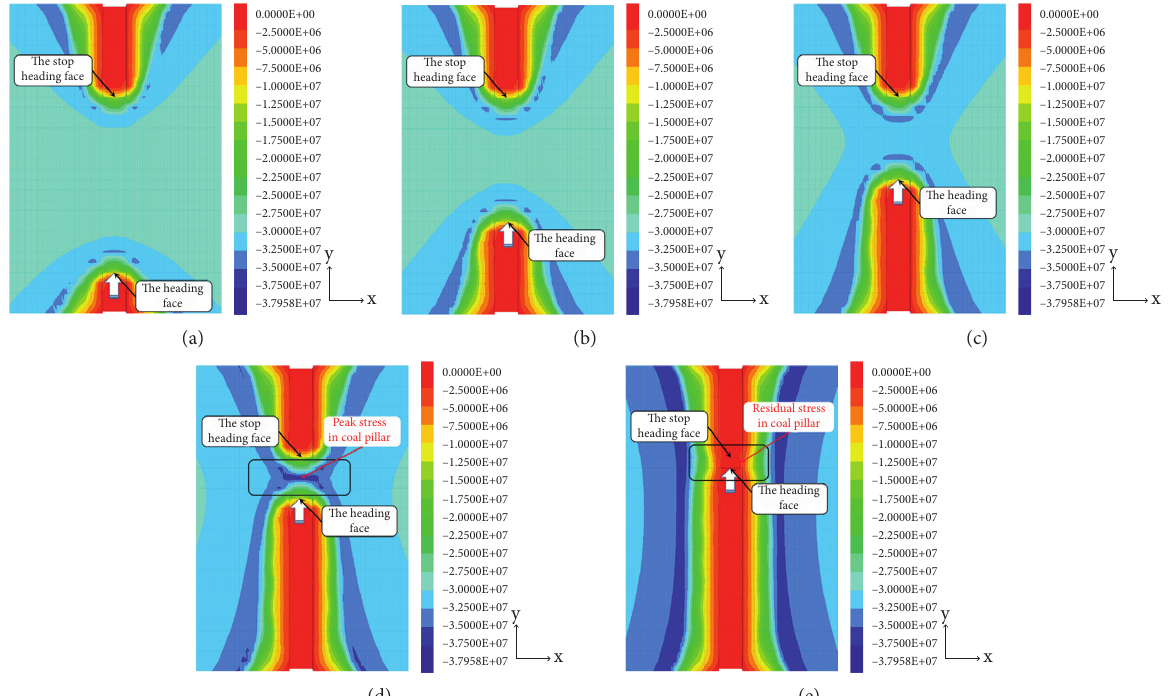
Figure 13: Distribution of surrounding rock stress along the direction of excavation. Roadway excavation was (a) 10m, (b) 20m, (c) 30m, (d) 40m, and (e)